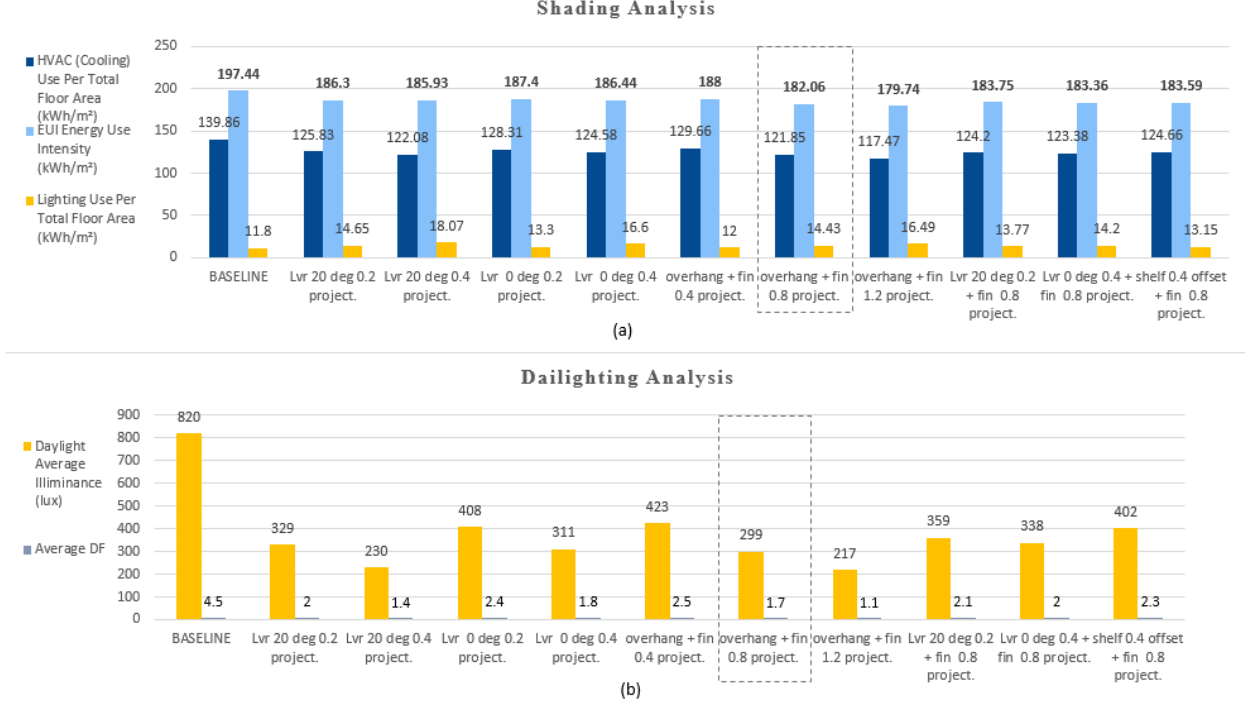
Figure 9. The effect of different external shading options on the total building energy use ( a ) and daylighting levels ( b ) of the west façade (best performance highlighted in dotted box).